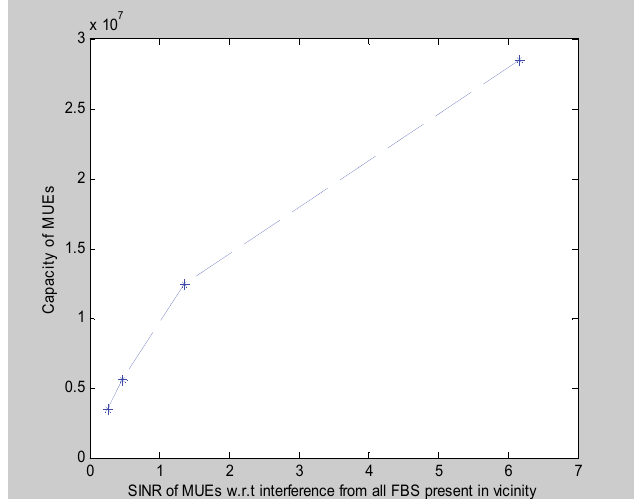
Fig. 8. SINR & Capacity of MUEs w.r.t. interference from